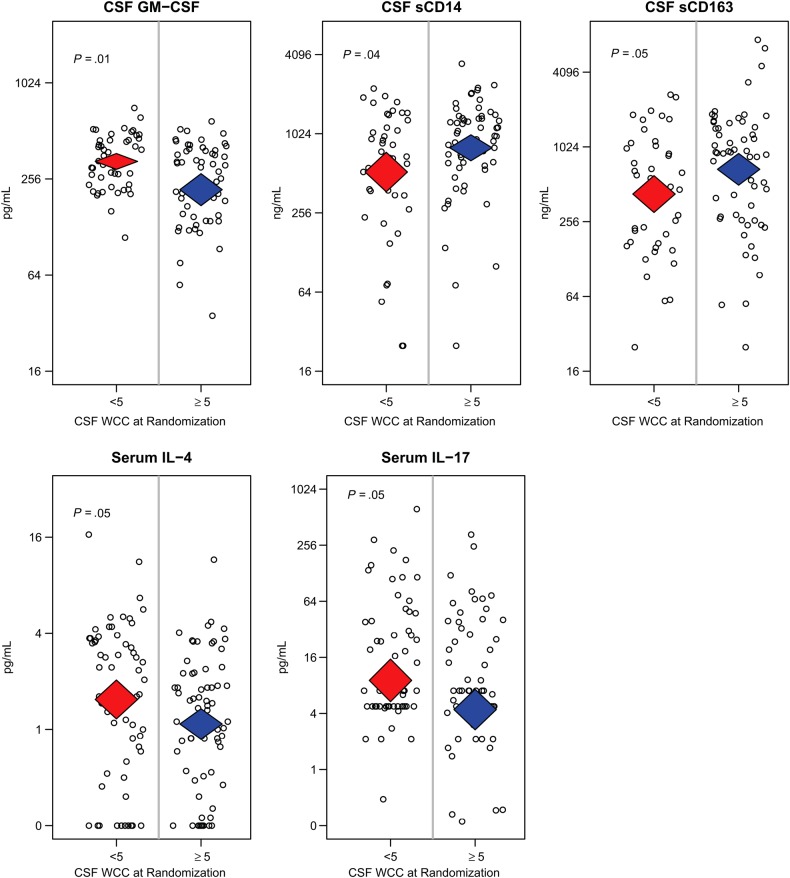
Differences in serum and cerebrospinal fluid (CSF) biomarkers between subjects with normal or raised CSF white cell count (WCC) at Cryptococcal Optimal ART Timing randomization (median amphotericin day 8). Participants who had a normal CSF WCC (<5/µL) at randomization had significantly higher serum interleukin (IL)-4, IL-17, and CSF granulocyte-macrophage-colony-stimulating factor (GM-CSF) levels, but significantly lower CSF sCD14 and sCD163 levels, compared to participants with raised CSF WCC (≥5/μL). Supplementary Table 4A and 4B present detailed data for CSF and blood, respectively.